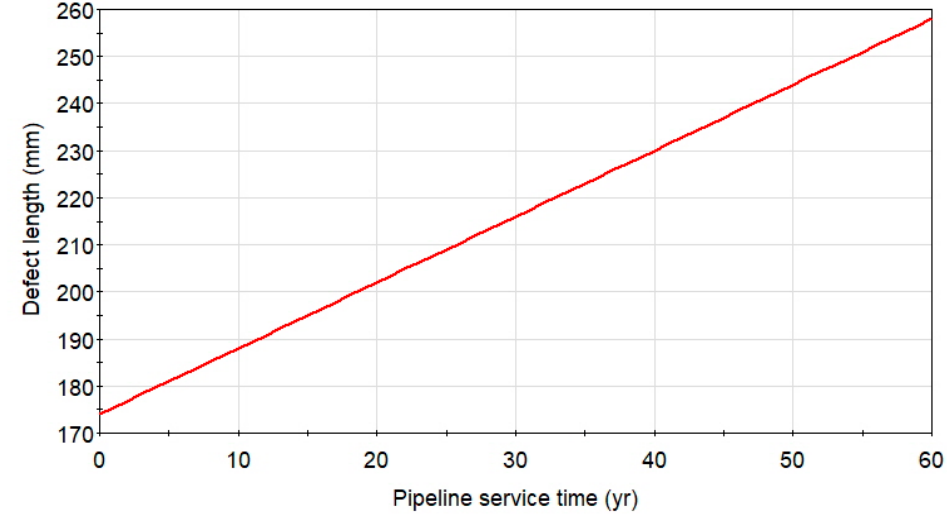
Figure 6. The linear length increment of the detected metal loss of the initial length l = 174 mm and a growth rate of 1.4 mm/year within the predicted pipeline service time.